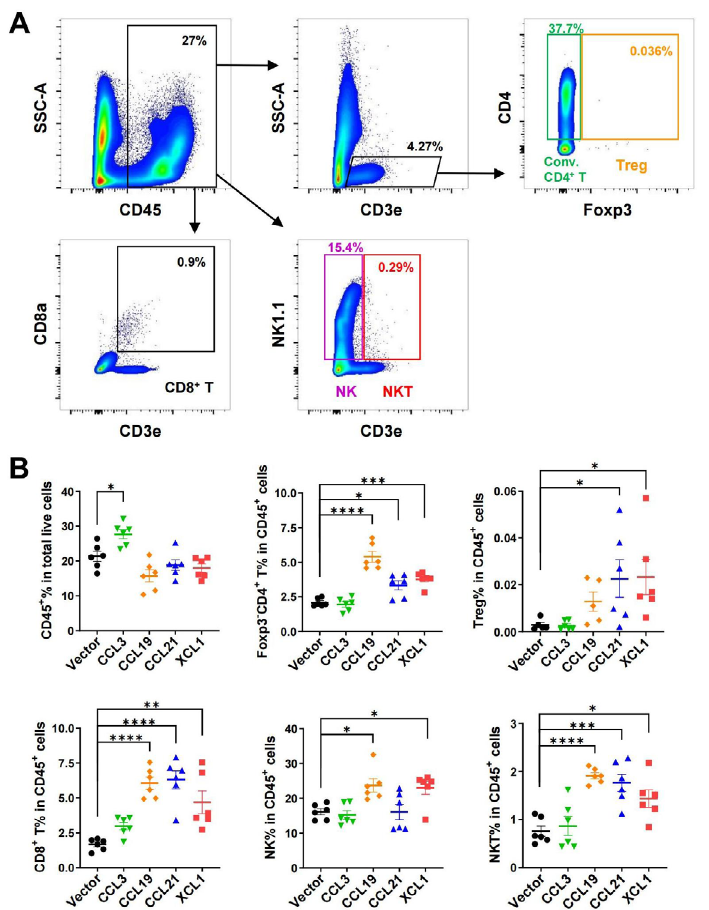
Figure 7. FACS analysis of tumor-infiltrating lymphocytes in MC38 tumor model. A. Gating strategies for conventional